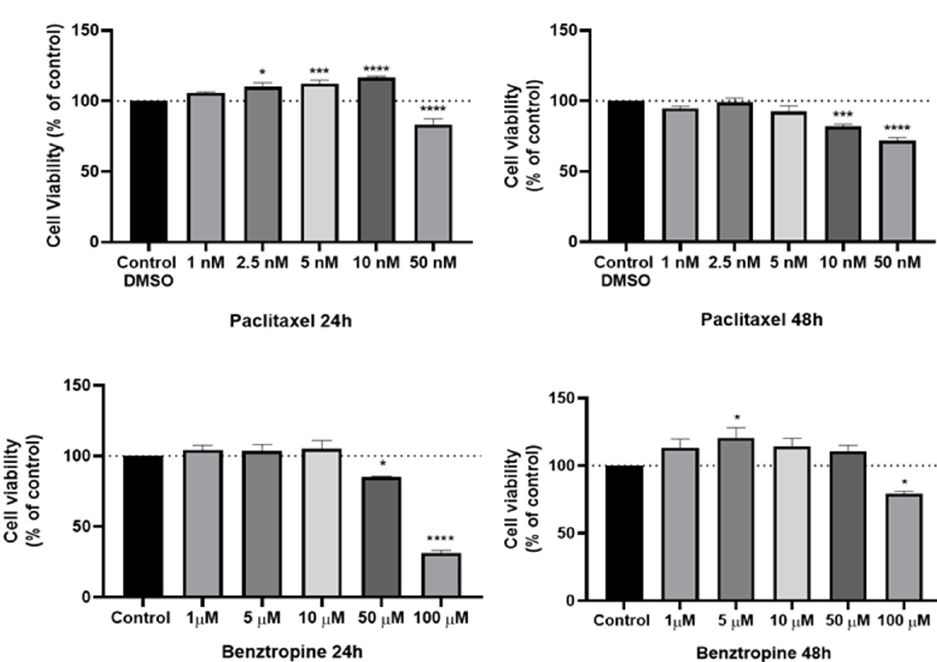
Figure 4. Results obtained with neutral red assay on cell viability (% of control) in MCF-7 cells treated with paclitaxel at 24 h and 48 h (upper charts) and those treated with benztropine at 24 h and 48 h (lower charts). * p < 0.05, *** p < 0.001., **** p < 0.0001.